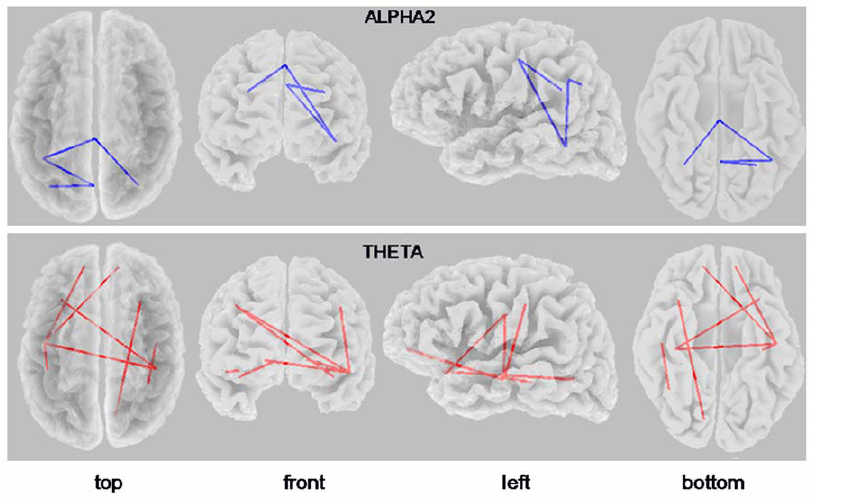
Figure 4. eLORETA wire diagram illustrating cortical areas with significantly decreased (blue wires; threshold: t= 2 3.49, p , 0.05 corrected) and increased (red wires; threshold: t=4.26, p , 0.05 corrected) alpha2 and theta lagged phase synchronization, respectively, in patients with Alzheimer’s disease vs. controls. Results are displayed on a transparent fiducial cortical surface. The points to which the lines are connected represent the center of the